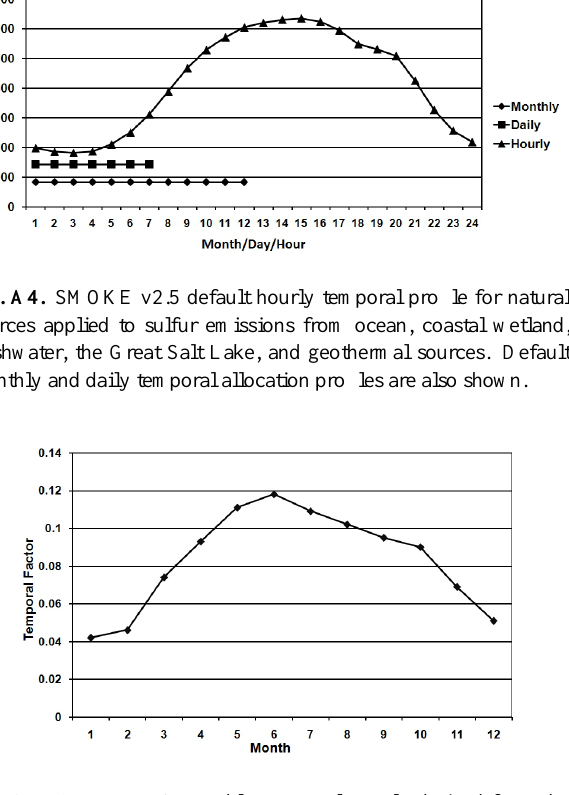
Fig. A5. Ocean DMS monthly temporal profile derived from the work of Kettle and Andreae (2000) applied to the annual mean flux of sulfur from the oceans as delineated by Kloster et al. (2006).